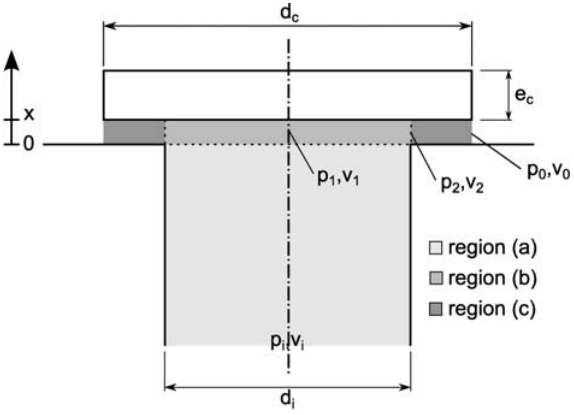
Fig. 2: Main geometrical characteristics and pressure dis- tribution in the valve for open